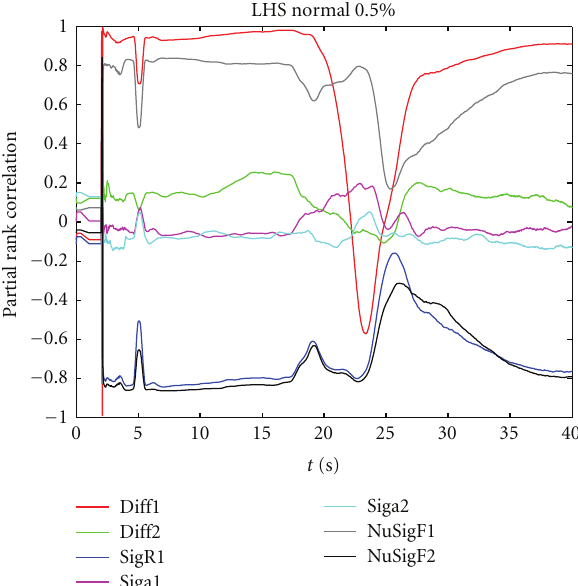
Figure 12: Partial rank correlation coe ffi cient LHS normal 0.5%, output variable:reactivity.